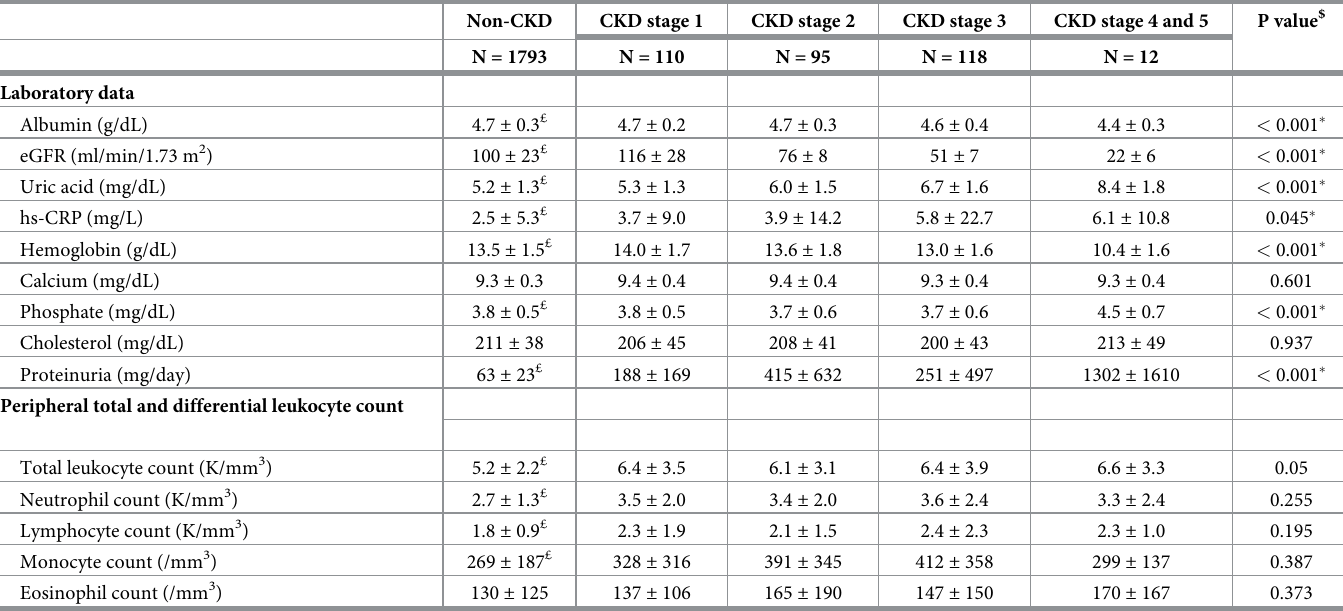
Table 2. Laboratory data of non-CKD and CKD patients with different CKD stages.